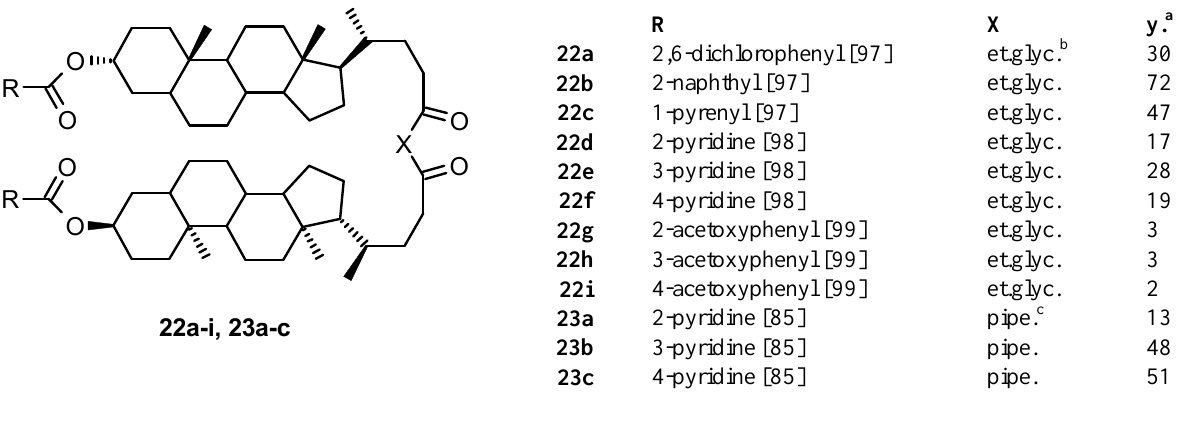
Figure 12. Structures and yields of bile acid based open-chain dimers 22a-i and 23a - c . a yield (%), b -OCH CH O-, c doubly unprotonated 2 2